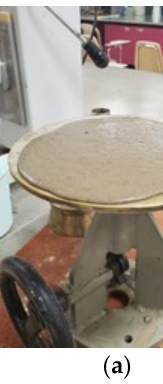
Figure 2. Effect of DCP content on the flowability of the mixture.